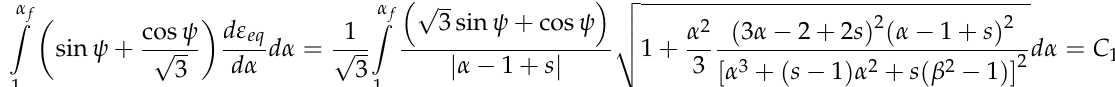
a w Here, is the value of at fracture initiation. The corresponding value of Here, α f is the value of α at fracture initiation. The corresponding value of ω can be w C found from Equation (46) and is denoted as ω f . Figure 9 depicts C 1 calculated from (54) for can be found from Equation (46) and is denoted as f . Figure 9 depicts 1 calculated several loading paths. These curves allow one to find the axial feeding at which fracture from (54) for several loading paths. These curves allow one to find the axial feeding at occurs for a given value of C 1 . C which fracture occurs for a given value of 1 .